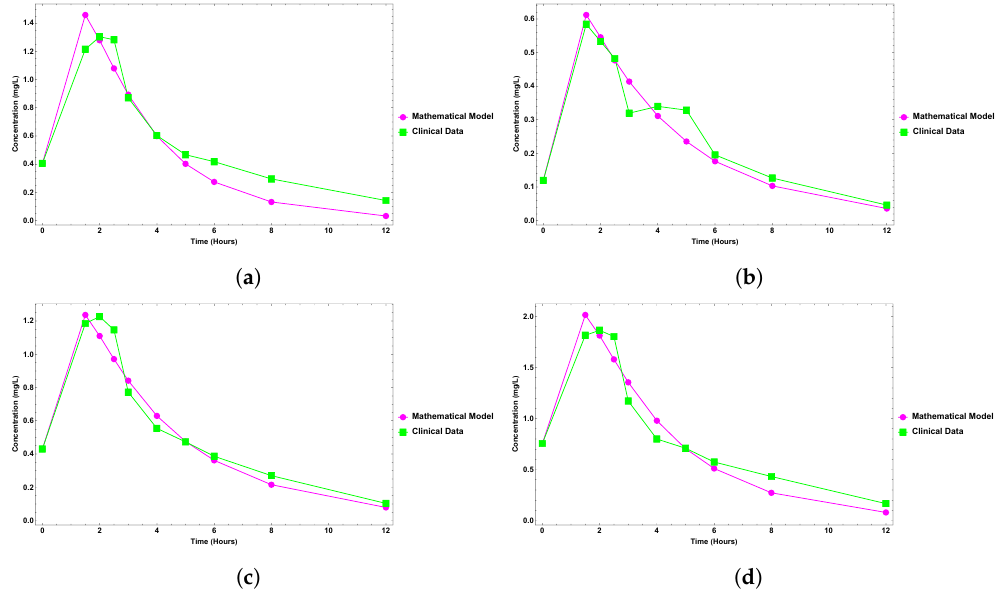
Figure 6. Ritonavir standard dose regimen and co-administration dose regimen. ( a ) 100 mg ritonavir. ( b ) 100 mg ritonavir + 600 mg rifampin. ( c ) 150 mg ritonavir + 600 mg rifampin. ( d ) 200 mg ritonavir + 600 mg